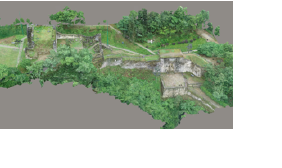
Figure 17 . Completed 3D data for Erdao Gate, Hailongtun, based on point cloud information.